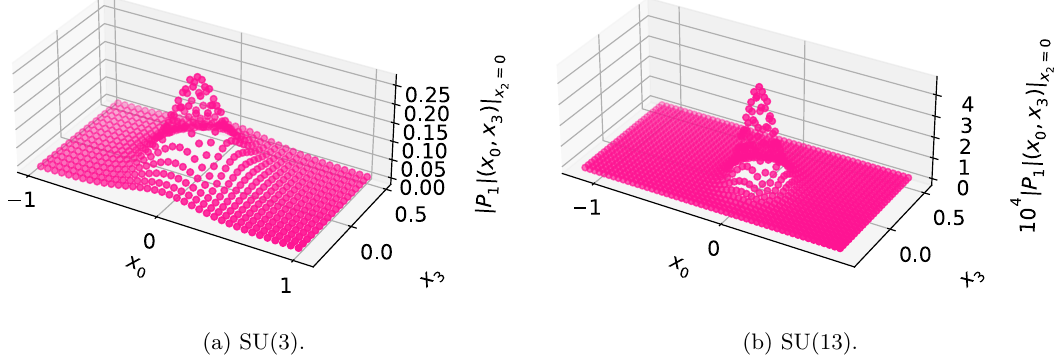
Figure 9. Modulus of P 1 , the Polyakov loop winding once in the x 1 direction, as a function of the coordinates in the 03 plane for x at the instanton center. Data points have been shifted so as to have 2 the maximum of the action profile at x = 0 . Note the change of vertical scale in the case of SU(13)